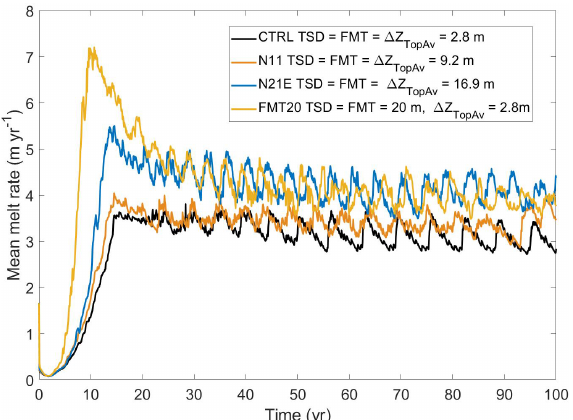
Figure 8. Simulated mean melt rates from experiments CTRL, Us- tarMean, and UstarIndep. The inset panel is the zoom of experiment UstarIndep in the y